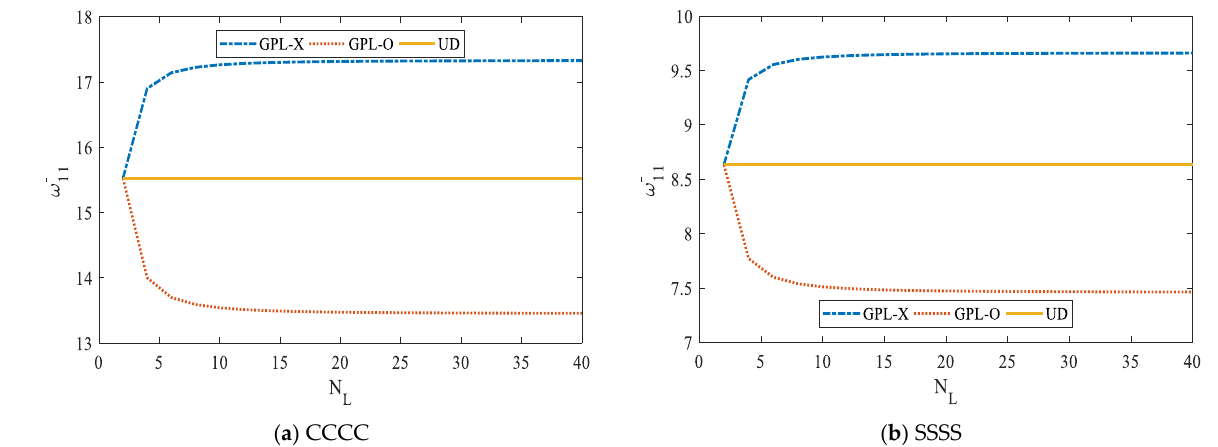
Figure 9. Dimensionless fundamental frequency vs. the number of layers, for different GPL distribution patterns